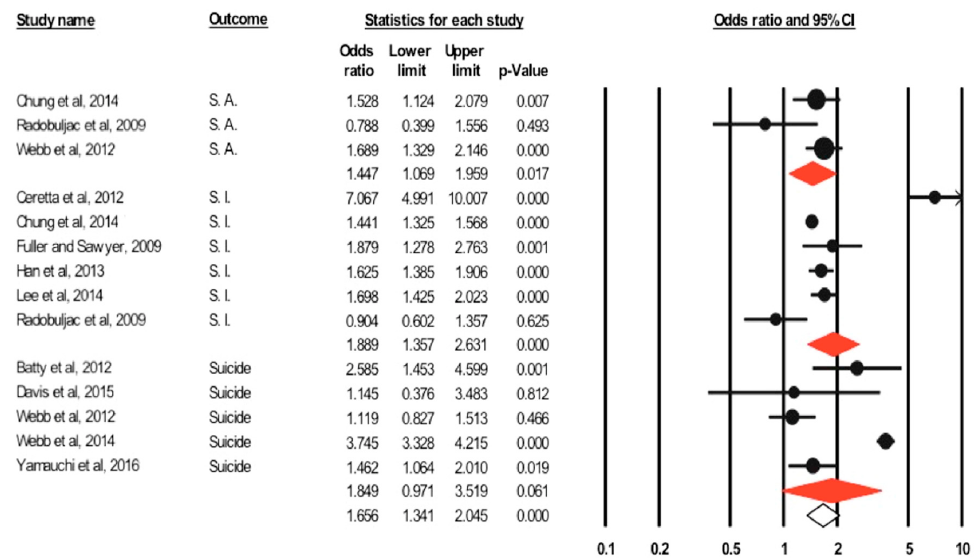
Figure 3. Forest plot of unadjusted odds ratio for suicidality and diabetes. SA: suicidal attempts, SI: suicidal ideation. Red diamonds represent pooled odds ratio for each outcome, while white diamond represent the overall odds ratio for the three outcomes.